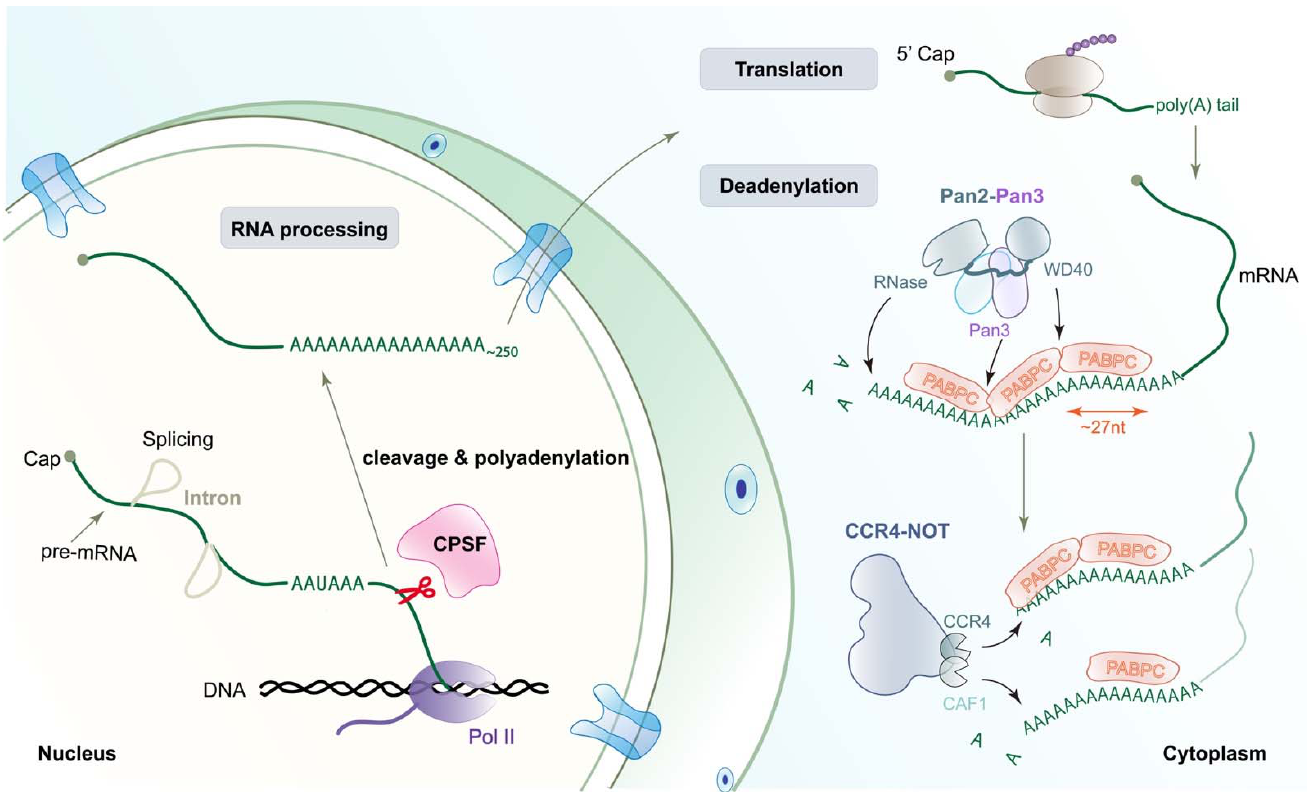
Figure 1. Schematic representation of polyadenylation and deadenylation. In the eukaryotic nucleus, primary RNA transcripts undergo extensive modifications to generate mature functional mRNA; this process is named RNA processing, which includes 5 ′ capping, splicing, and 3 ′ polyadenylation. It must be noted that 3 ′‐ end processing includes two steps, cleavage at a specific site (the scissors, indicating the site of cleavage by CPSF) and addition of a poly(A) tail at the same site. Then, the mature mRNAs with long poly(A) tails will be exported to the cytoplasm and translated into protein. PABPC covers the poly(A) tail, protecting mRNA from non ‐ specific degradation and meanwhile promoting poly(A) tail removal or shortening via interactions with PAN2 ‐ PAN3 and CCR4 ‐ NOT complexes (deadenylation). Pan3 and the WD40 domain in Pan2 recognize the interface between different PABP molecules. Deadenylase CCR4 works on PABPC ‐ bound A tails, whereas CAF1 only trims naked poly(A) RNA. CPSF, cleavage and polyadenylation specificity factor.